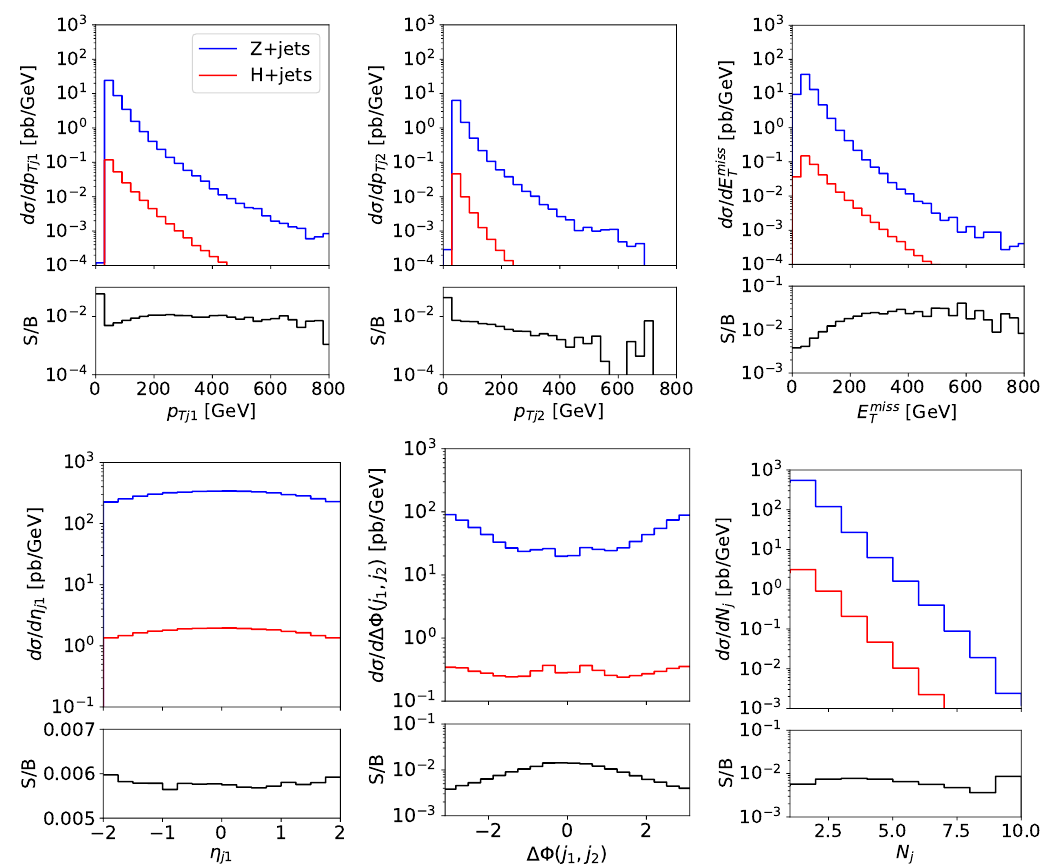
Figure 8: Kinematic distributions for the H + jets signal (red) and leading Z + jets background (black), along with the signal-to-background ratio. We show the leading p , the second p , / E , the pseudorapidity of the leading jet, ∆ φ of the leading two T , j T , j T jet, and the jet